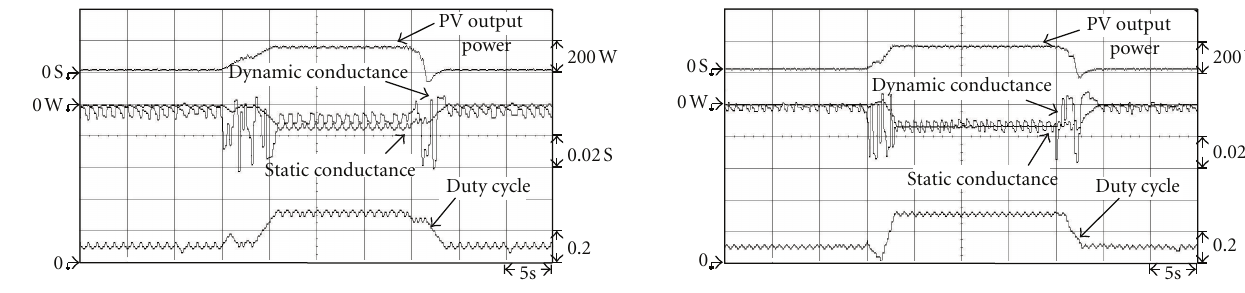
Figure 18: Measured output power, dynamic conductance, static conductance, and duty cycle waveforms of a PV module array using the traditional INC method under irradiation that increased from 450W/m 2 to 750 W/m 2 and then dropped back to 450W/m 2 .